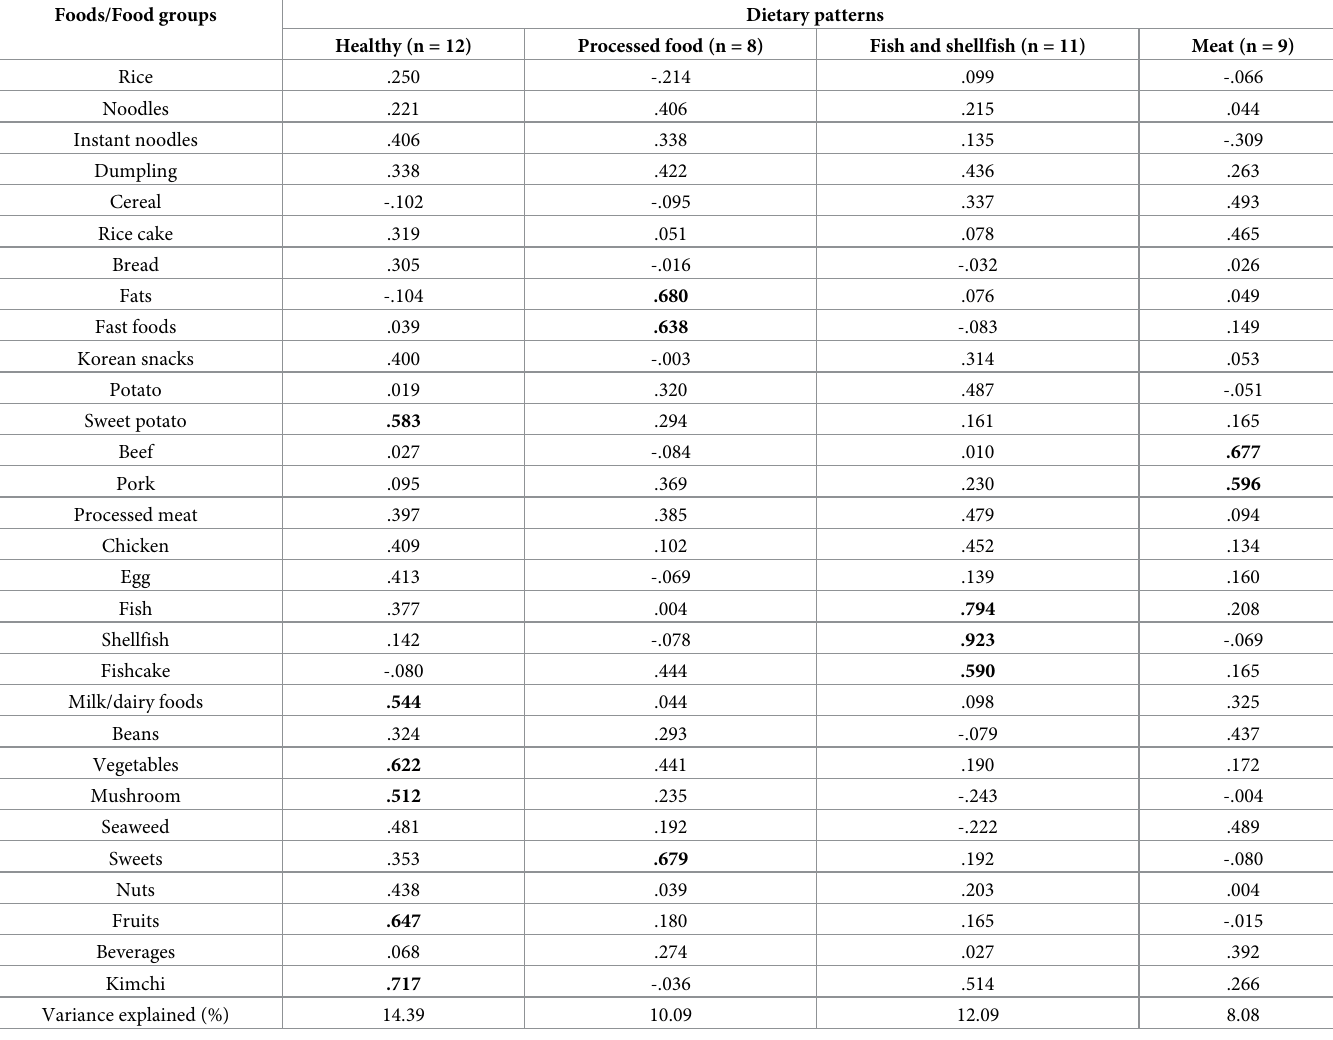
Table 2. Factor loadings for the major dietary patterns derived from the principal components analysis with orthogonal rotation. Foods/Food